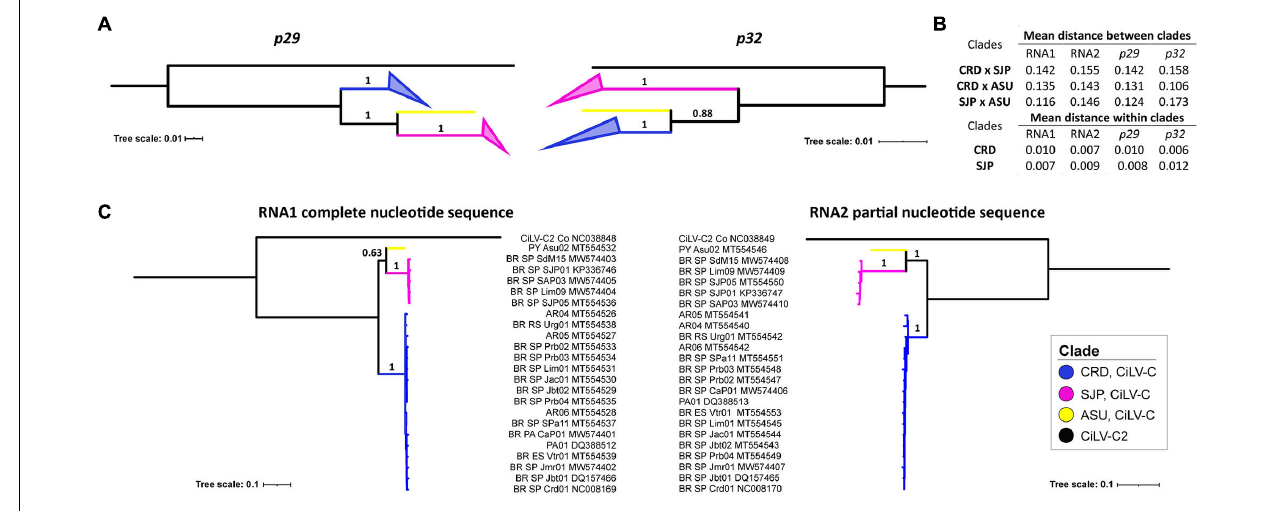
FIGURE 4 | Phylogenetic relationships and genetic distances among CiLV-C strains. Phylogenetic trees were generated by Bayesian inference using MrBayes and based on p29 (190 isolates, 795 nts) and p32 (270 isolates, 288 nts, partial) (A) , and the complete sequences of the RNA1 molecules and partial sequences of the RNA2 molecules ( p61 , p32, and p24 ) of 23 isolates of CiLV-C (B) . Inter- and intra-clade nucleotide distances were calculated considering independent ORFs and complete genomic molecules (C) . The maximum clade credibility trees were generated with 6,000,000 generations and using the appropriate sequences of CiLV-C2_Colombia (NC038848 and NC038849) as an outgroup. Tree branches were identified according to CiLV-C